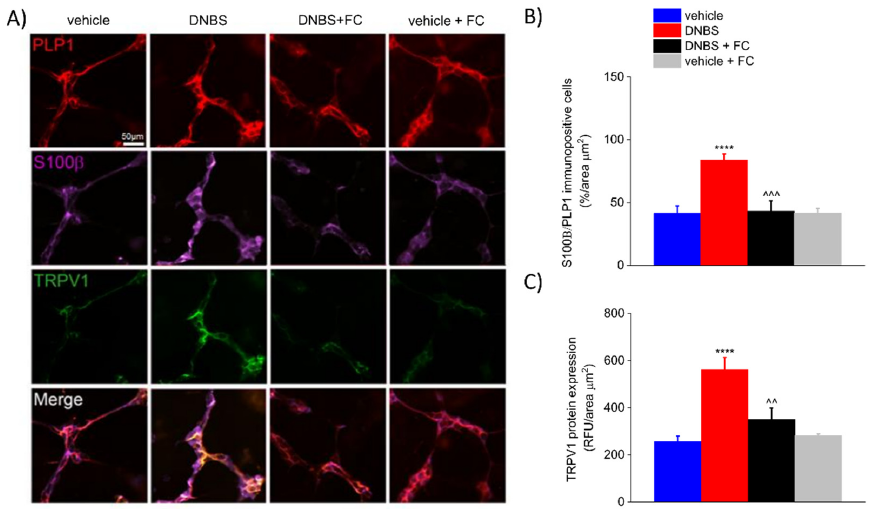
Figure 5. Effect of systemic fluorocitrate on S100 β and TRPV1 increased expression within the colonic myenteric plexus of DNBS rats at day 7. ( A ) Immunofluorescence images show the expression of PLP1 (red), S100 β (purple), and TRPV1 (green) in the myenteric plexus of the colon and ( B , C ) relative immunolabeling quantification at day 7 after colitis induction. Data were analysed by one-way ANOVA and Bonferroni post-hoc. Results are expressed as a mean ± SEM of the percentage of PLP1 immunopositive cells that co-express S100 β per area unit ( µ m 2 ) of n assessments. Results about TRPV1 expression are expressed as average relative fluorescence units (RFUs) ± SEM per area unit of ( µ m 2 ) of n assessments. **** p < 0.0001 vs. vehicle, ˆˆˆ p < 0.001 and ˆˆ p < 0.01 vs. DNBS. Original magnification: 20 × . Scale bar: 50 µ m.